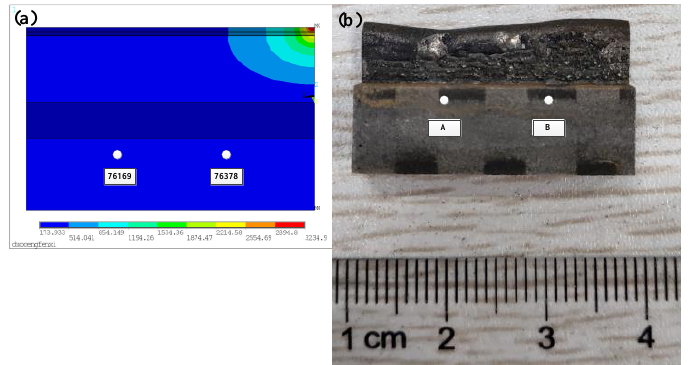
Figure 8. Comparison of observation points: ( a ) simulation, ( b ) experiment.